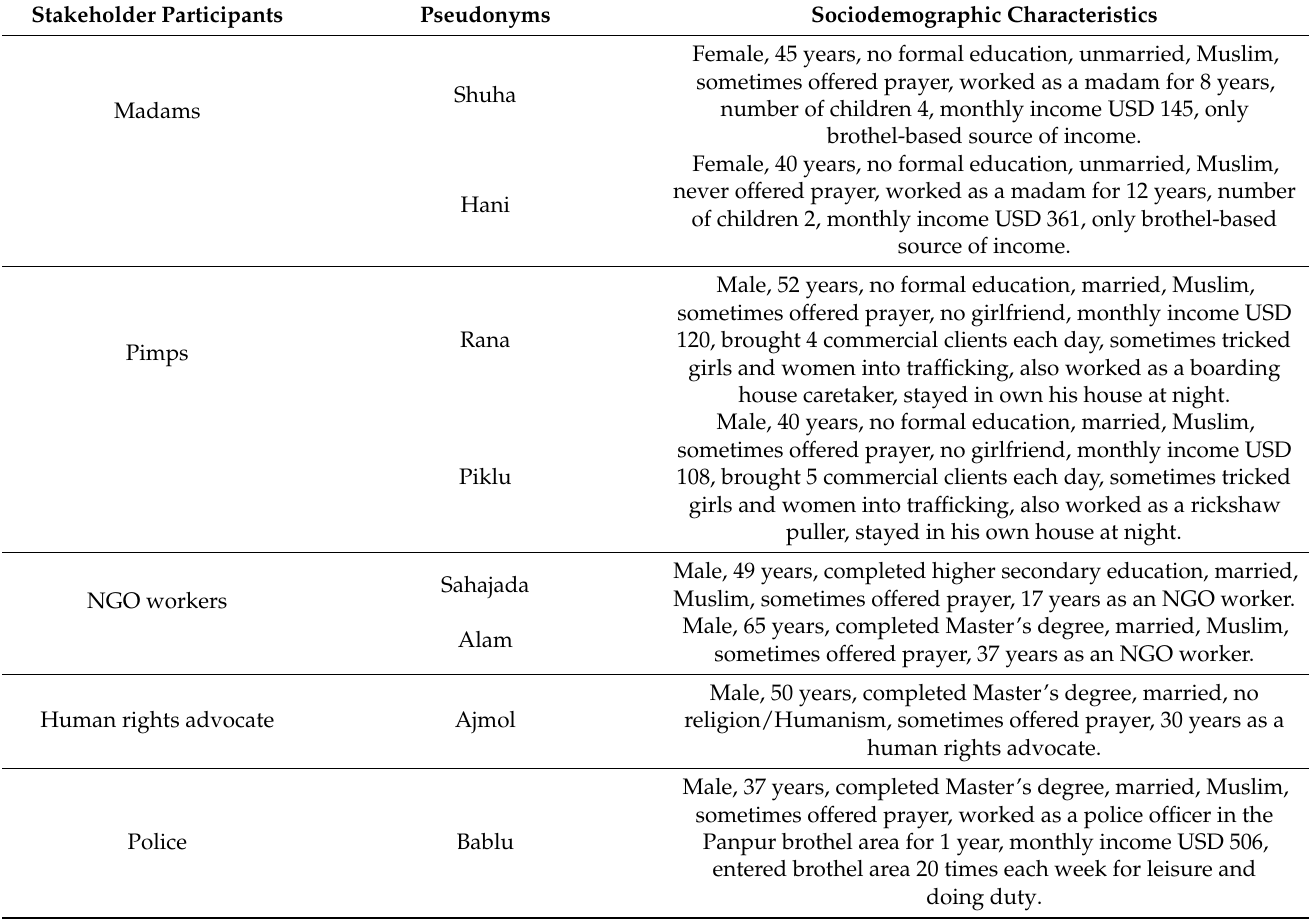
Table 2. Sociodemographic characteristics of stakeholder participants in the in-depth